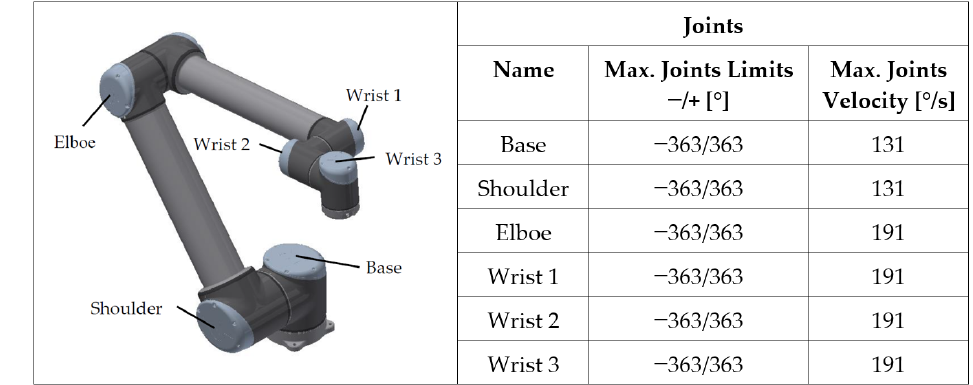
Figure 2. The names of individual joints, their maximum limits of rotation and velocity.